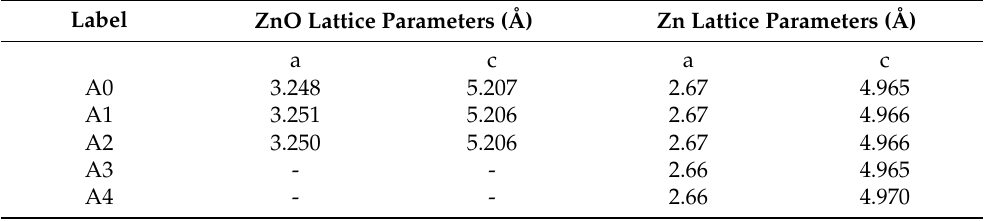
Table 2. Calculated la tt ice parameters. The la tt ice parameters a and c were calculated using the Equation (1) and the XRD peaks at 31.85° (100) and 34.45° (002) for ZnO, and at 36.34°(002) and 39.31° (100) for Zn. The e ff ect is due to the change in the deposit temperature. Label